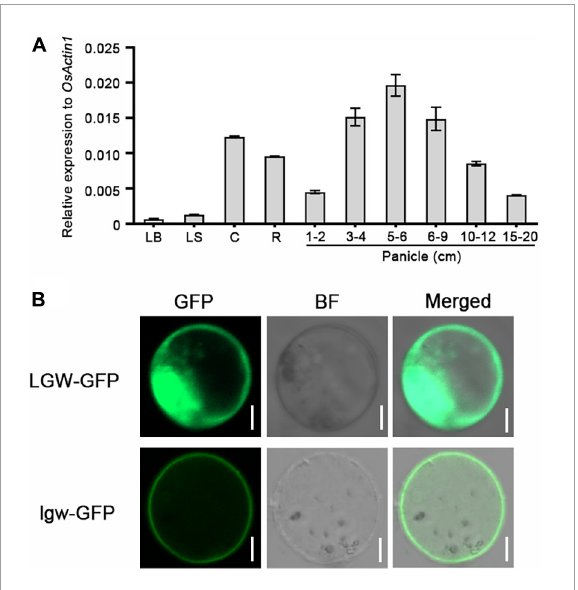
FIGURE4 Expression pattern and subcellular localization of LGW. (A) The expression level of LGW in various rice organs. LB, leaf blade; LS, leaf sheath; C, culm; R, root; Panicle (1–2, 3–4, 5–6, 6–9, 10–12, 15–20 cm). The Actin1 was used as an internal control. (B) The subcellular localization of LGW and lgw. LGW-GFP and lgw-GFP were expressed in rice protoplast, bars = 20 µ